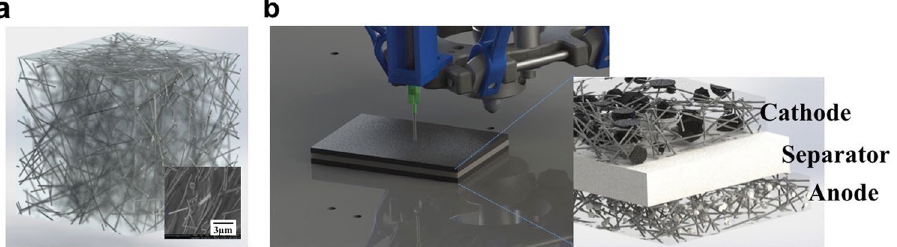
Figure 1. Schematic designs of cellulose composite and 3D printing of battery composites. ( a ) Computer aided design (CAD) model of AgNW/CMC 3D Conductor. Inset shows the scanning electron microscopy (SEM) image of the AgNW/CMC 3D Conductor, ( b ) CAD representation of three-layered 3D printed